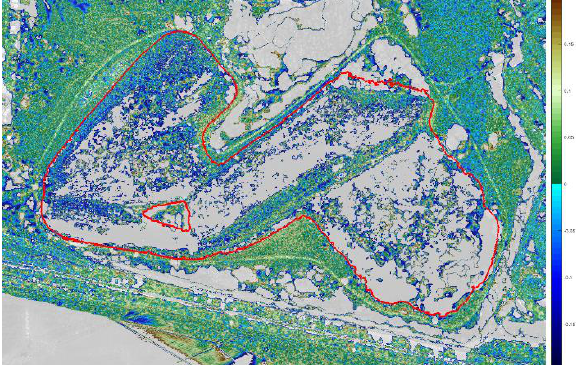
Figure 8. Height differences over in interval of ±0.2m between laser- and image-DEM’s.